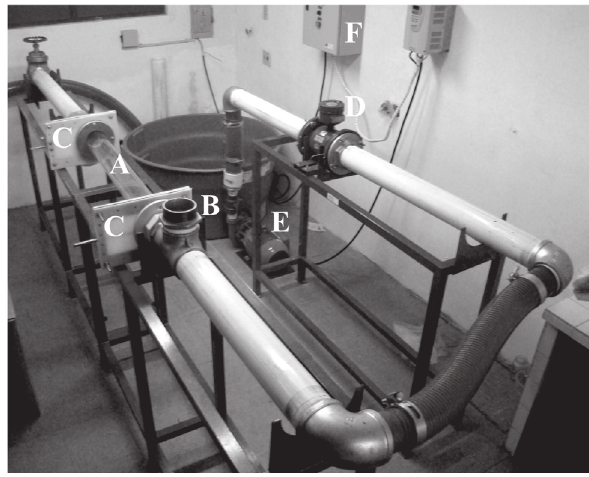
Figure 1. General view of the apparatus with indications of its com- ponents.